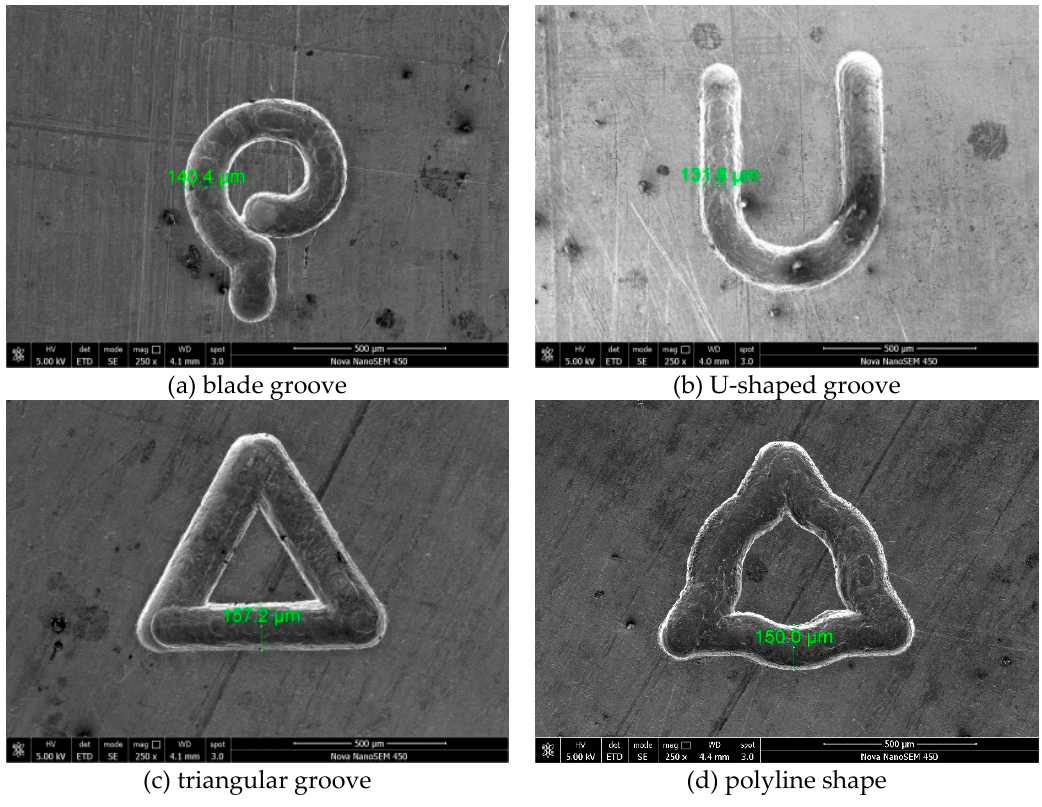
Figure 15. Typical machining results.